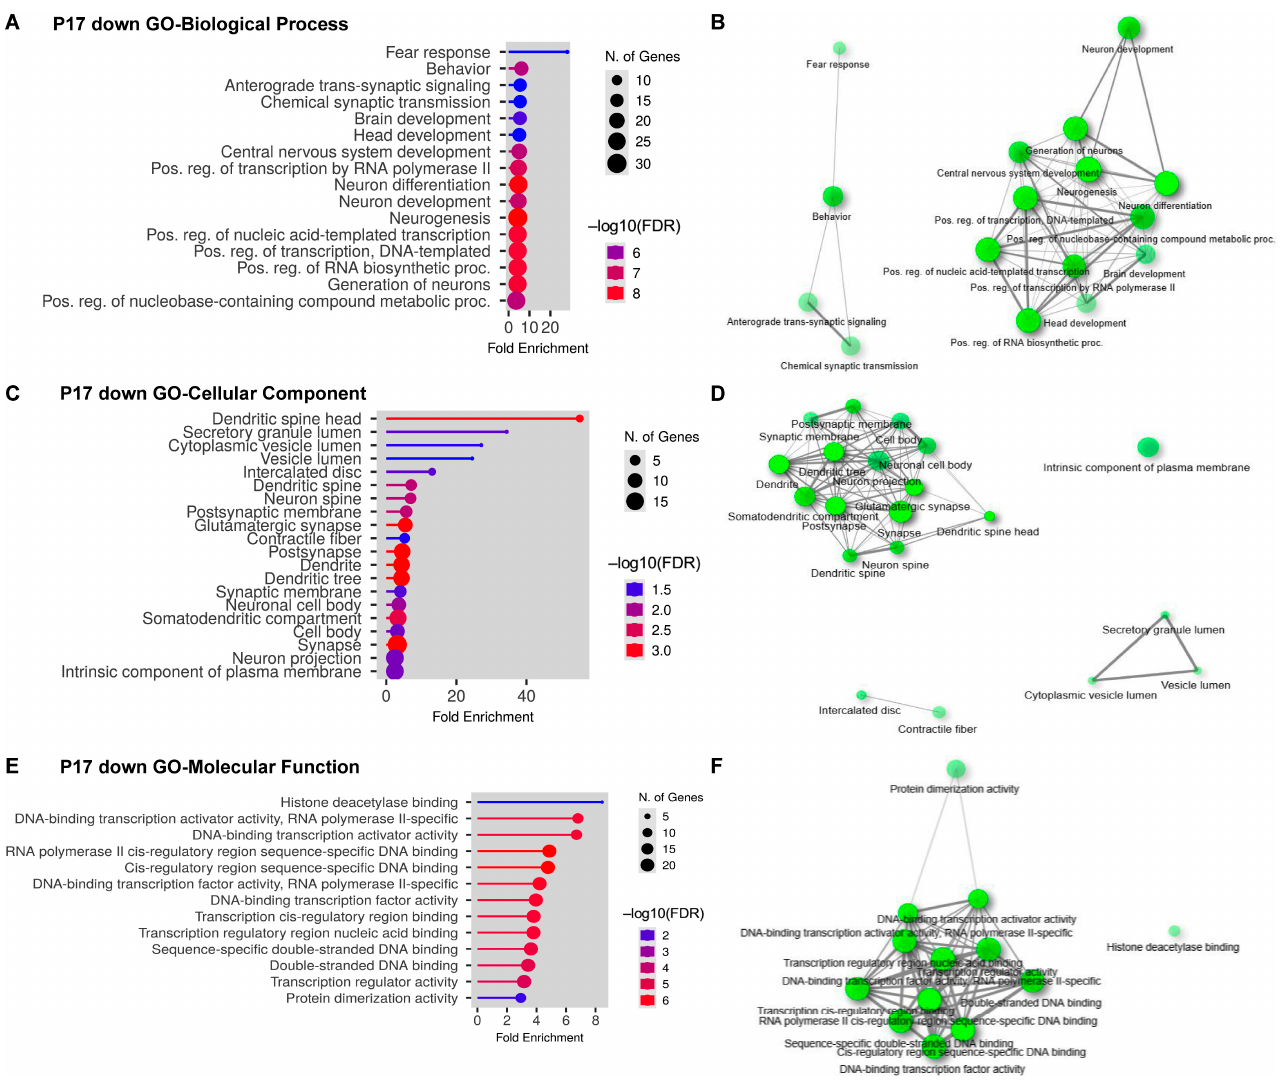
Figure 4. GO analysis of DEGs that are downregulated at P17. ( A ) Bar dot plot of GO analysis of biological process on downregulated DEGs from brains at P17. ( B ) Network plot of GO analysis of biological process on downregulated DEGs from brains at P17. ( C ) Bar dot plot of GO analysis of cellular component on downregulated DEGs from brains at P17. ( D ) Network plot of GO analysis of cellular component on downregulated DEGs from brains at P17. ( E ) Bar dot plot of GO analysis of molecular function on downregulated DEGs from brains at P17. ( F ) Network plot of GO analysis of molecular function on downregulated DEGs from brains at